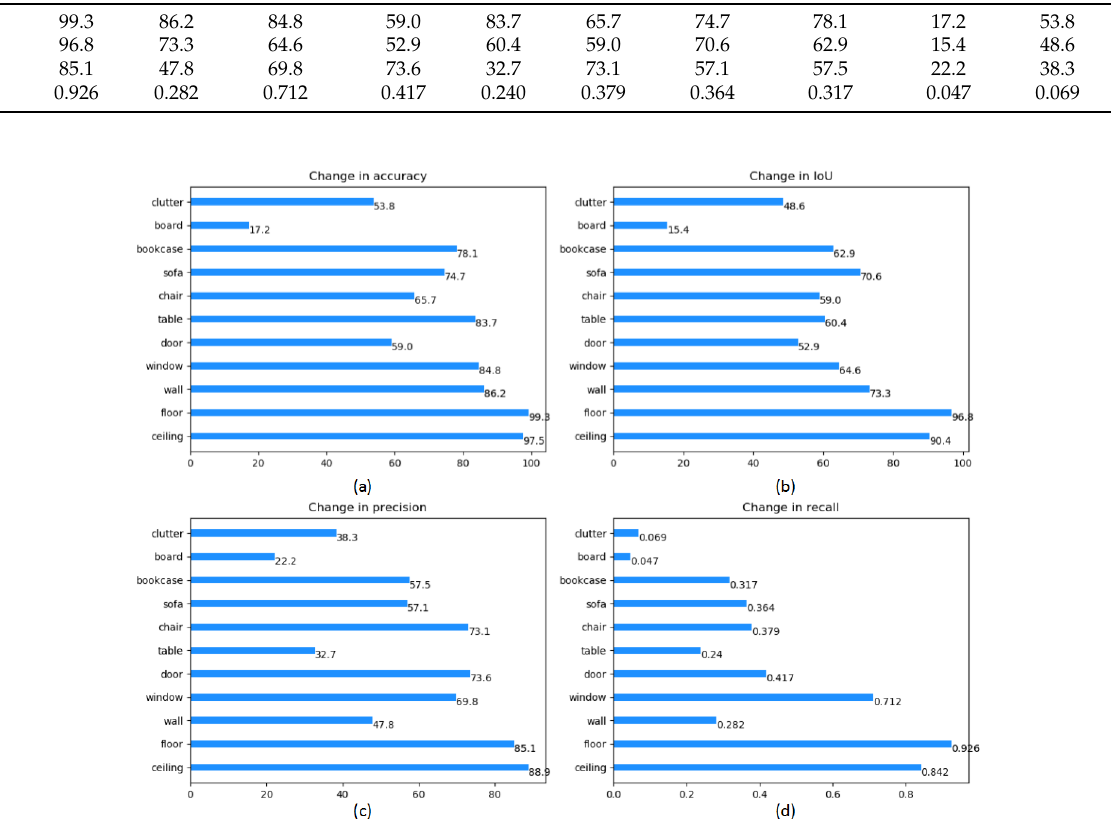
Figure 9. Semantic segmentation mIoU, oAcc and mRecall on S3DIS [36]. ( a ) is accuracy results of semantic segmentation. ( b )is IoU results of semantic segmentation, ( c ) is precision results of semantic segmentation, ( d ) is recall results of semantic